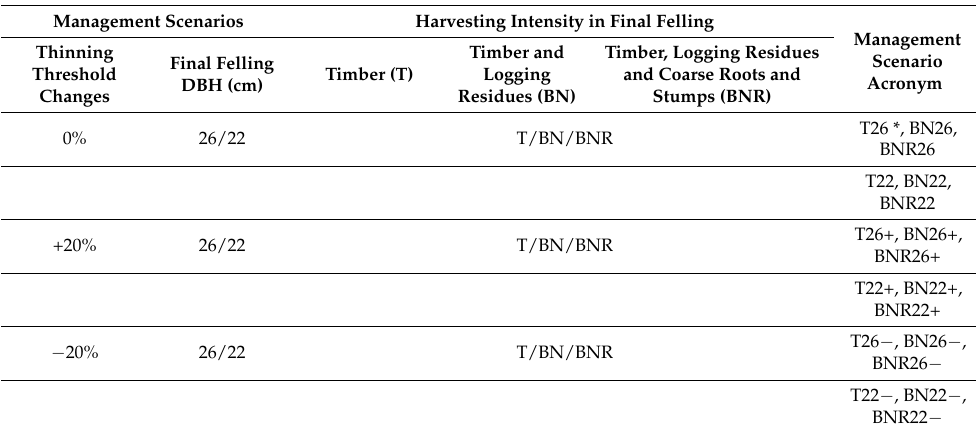
Table 1. Forest management scenarios (baseline and alternative forest management scenarios) and biomass harvest intensities utilized for the study. Baseline management followed current recommendations for thinning and final felling made at tree diameter at breast height (DBH) of 26 cm. In the alternative scenarios, changes in thinning thresholds (+/ − ), DBH in final felling (26/22 cm) and harvesting intensity (T/BN/BNR) were